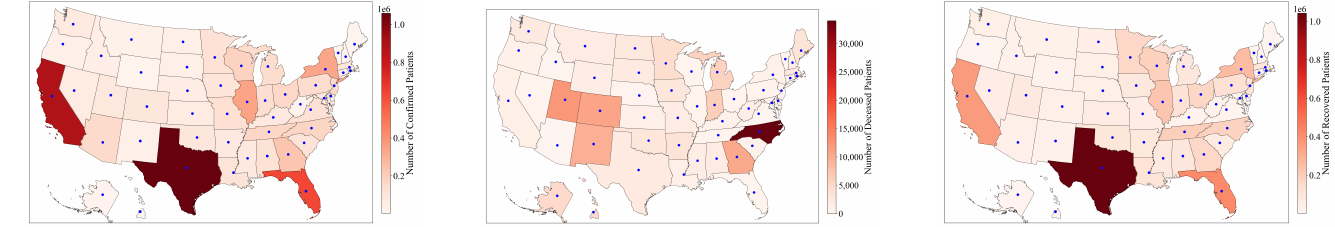
Figure 1. The number of confirmed, deceased and recovered patients in the U.S. on 3 December